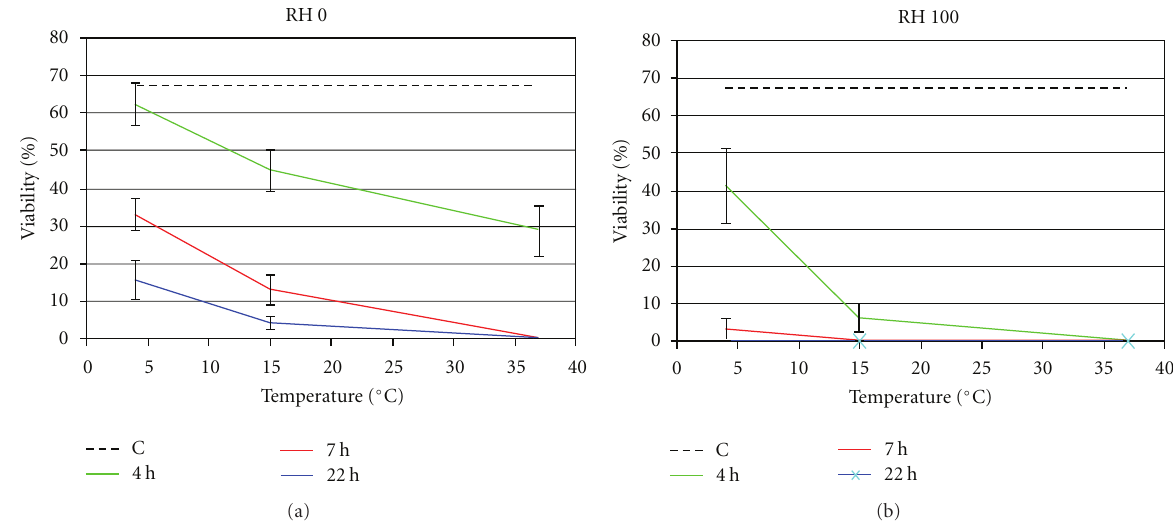
Figure 6: E ff ect of temperature (4, 15, and 37 ◦ C) and time (4, 7, and 22 hours) on pollen viability of C. emerus under dry (RH 0) and wet (RH 100) conditions. Dotted lines indicate viability at the beginning of the experiment and bars confidence intervals ( P < 0 . 05).